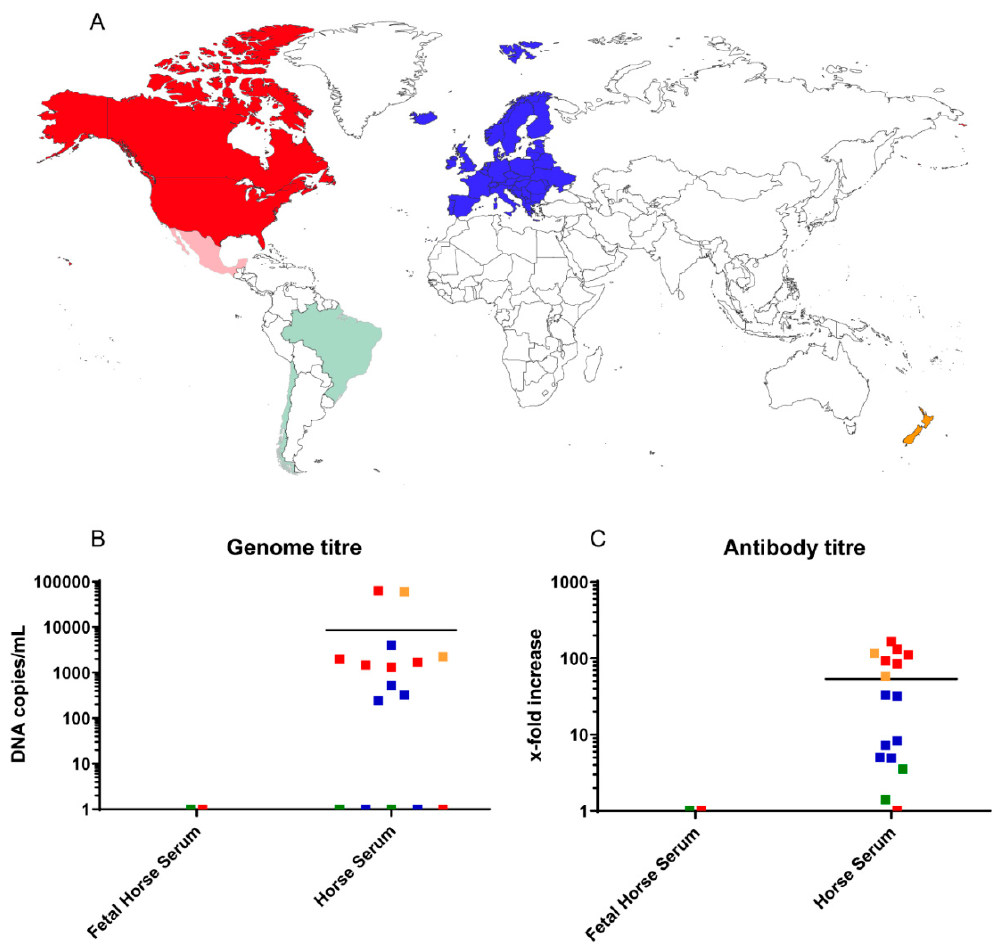
Figure 2. The origin of the serum pools is indicated on a world map ( A ). Reduced opacity indicates EqPV-H negative serum pools. Graphs ( B ) and ( C ) show the correlation of age (determined by the serum type) and origin on EqPV DNA and antibody prevalence, respectively. Every dot represents the mean of 5 technical replicates performed in two independent measurements. Negative samples were assigned the value 1. Red color corresponds to North America, while sera from South American countries are colored green. Blue indicates serum samples originating from Europe and orange belong to samples from Oceania (A–C).